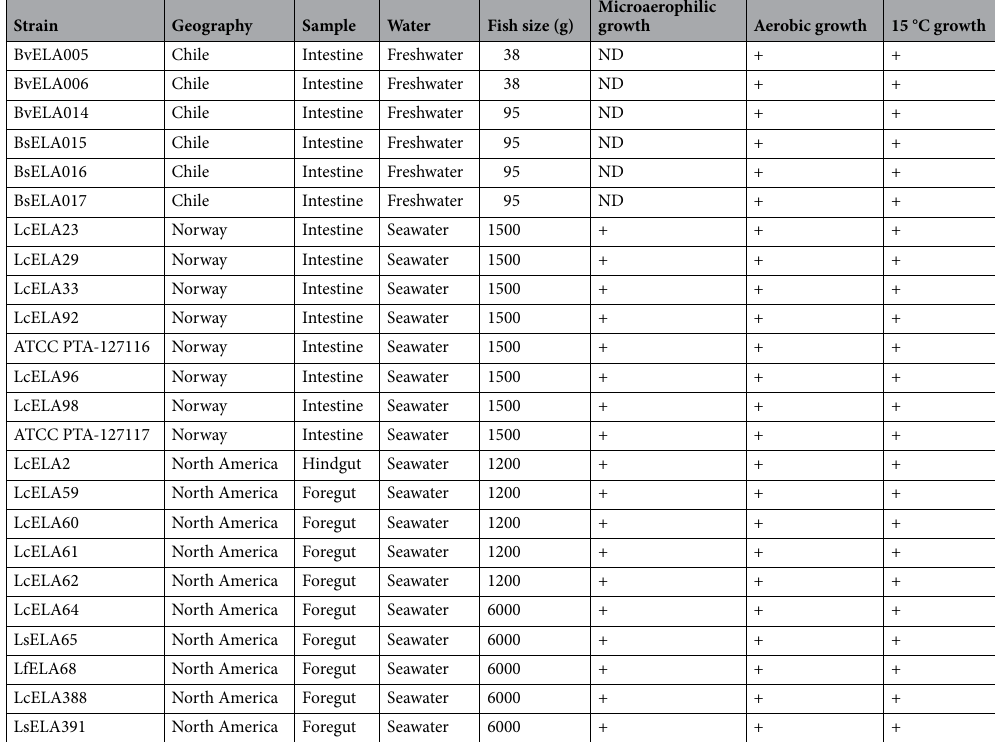
Table 4. Bacillus and Lactobacillus isolates and their growth profiles. Bv: B. velezensis , Bs: B. subtilis , Lc: L. curvatus , Ls: L. sakei , Lf: L.